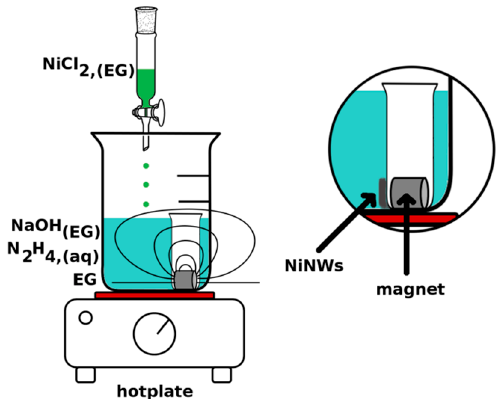
Figure 5. The method of synthesis used in the study. Only a selection of magnetic field lines are shown for the sake of clarity.